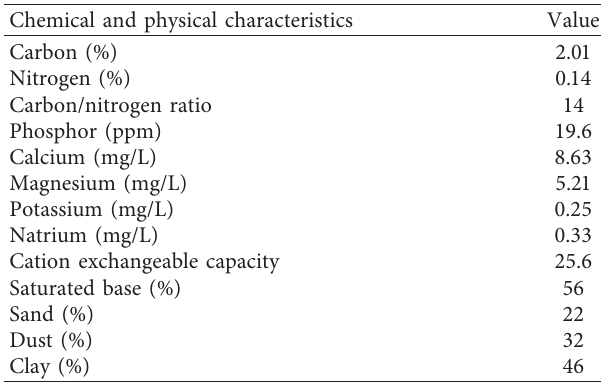
Table 4: Chemical and physical characteristics of the soil in the study